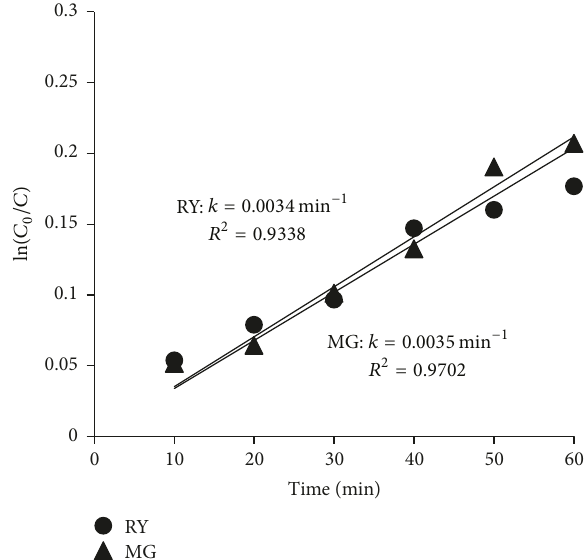
Figure 4: Plot of the first-order equation for (electrocoagulation) removal kinetics of malachite green (MG) and Remazol yellow (RY) in aqueous